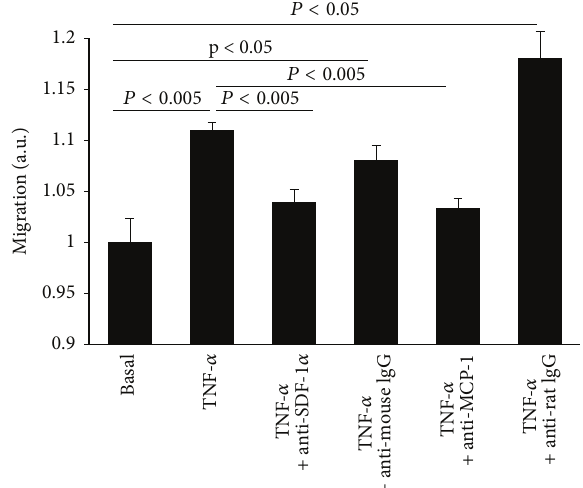
Figure 4: SDF-1 𝛼 - and MCP-1-dependent migration of MSC in vitro . Migration of MSC (in arbitrary units) towards basal conditioned medium of HL-1 cardiomyocytes and that of HL-1 cardiomyocytes stimulated with TNF- 𝛼 , in the presence or absence of a SDF- 𝛼 -antibody, MCP-1-antibody, or IgG-antibody. Columns represent mean ± SEM with 𝑛 = 4